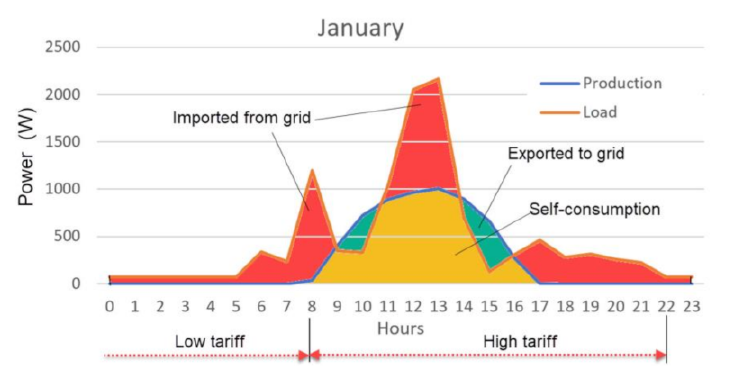
Figure 7. Average hourly profile of electricity consumption and production for July. The choice of the measurement time interval has an impact on the appearance of the electricity consumption profile, i.e., on the results of the analysis. Steps of 5 min, 15 min, and 1 h are mentioned in the literature. The longer the time step, the higher the amounts for ( SC ) and ( SS ). The difference between ( SC ) for a step of 5 min and 1 h on an annual basis can be 3.2%, while daily it can be more than 5% [4]. Accordingly, for our case of selecting a time step of 1 h, it can be assumed that the error in the analysis results does not exceed 5%. In general, production and consumption profiles rarely match, leading to a low SS or SC value. In the case of excess electricity (production greater than consumption),